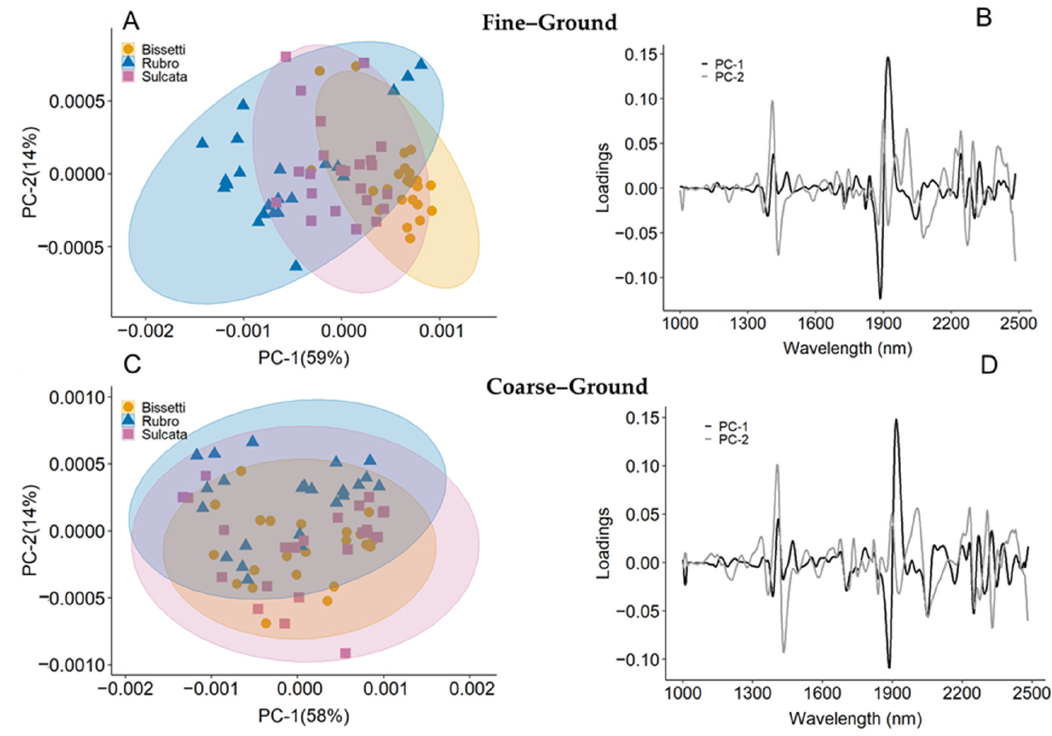
Figure 5. PCA scores plot ( A ) and loadings plot ( B ) for spectra collected from Fine–Ground bamboo samples. PCA scores plot ( C ) and loadings plot ( D ) for spectra collected from Coarse–Ground bamboo